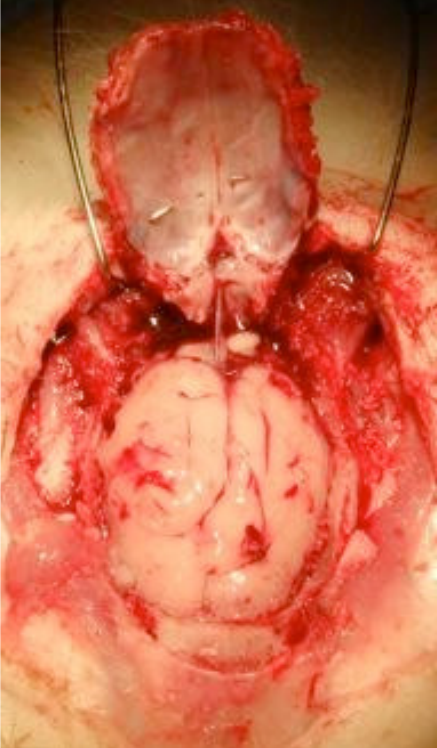
FIGURE 4 - Removal of bone segment. Internal view showing the spring struts and the dura mater